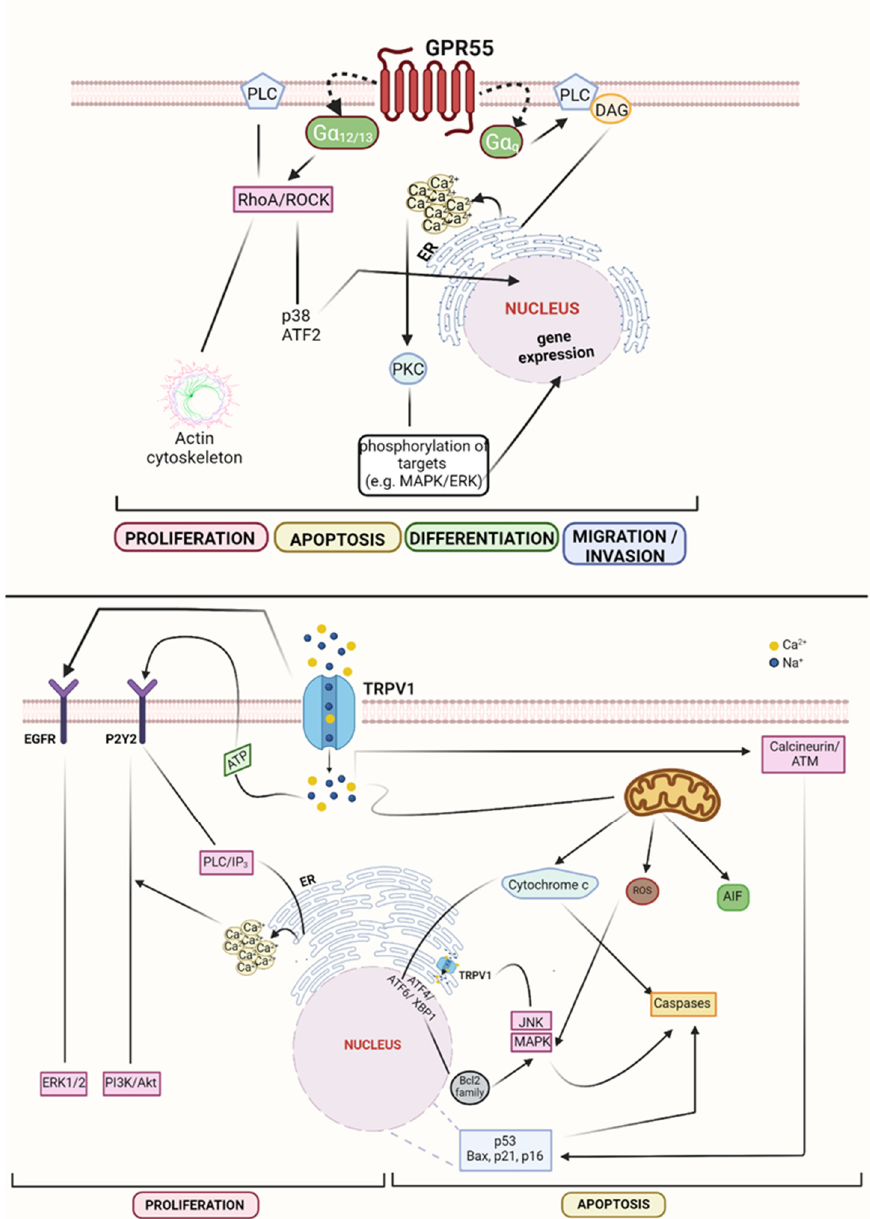
Figure 3. Non-canonical CBRs signalling in cancer. GPR55 modulation leads to proliferation, apoptosis, differentiation, and migration, through different molecular pathway. TRPV1-dependent mechanisms induce proliferation ( ↑ ERK1/2; ↑ PI3K/Akt), or apoptosis ( ↑ cytochrome c/caspases; ↑ ROS/JNK/MAPK; ↑ AIF; ↑ p53/Bax/p21/p16). Created with BioRender.com. PPAR α and PPAR γ represent novel discovered CBRs. PPAR α is widely distributed